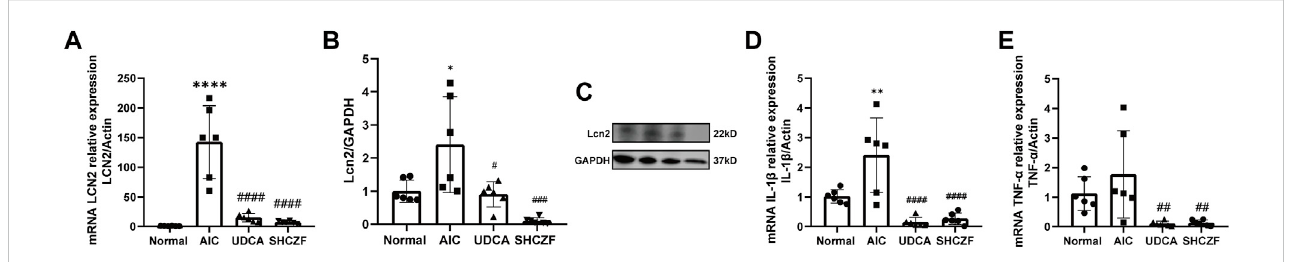
FIGURE 9 Expression of LCN2 and pro-in fl ammatory cytokines. (A) mRNA expression of LCN2, (B) protein expression of LCN2, (C) WB bands of Lcn2 and GAPDH, (D) mRNA expression of TNF- α , (E) mRNA expression of IL-1 β